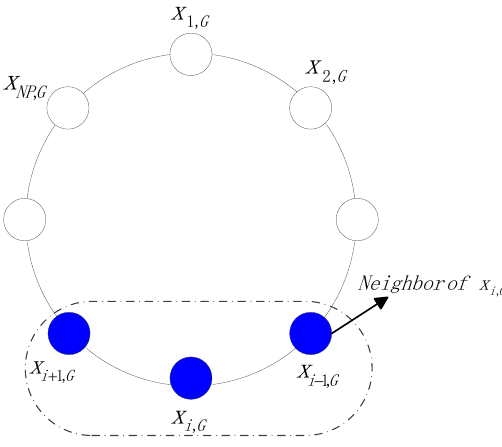
Figure 2. Ring topology of H-neighborhood in PSONHM.